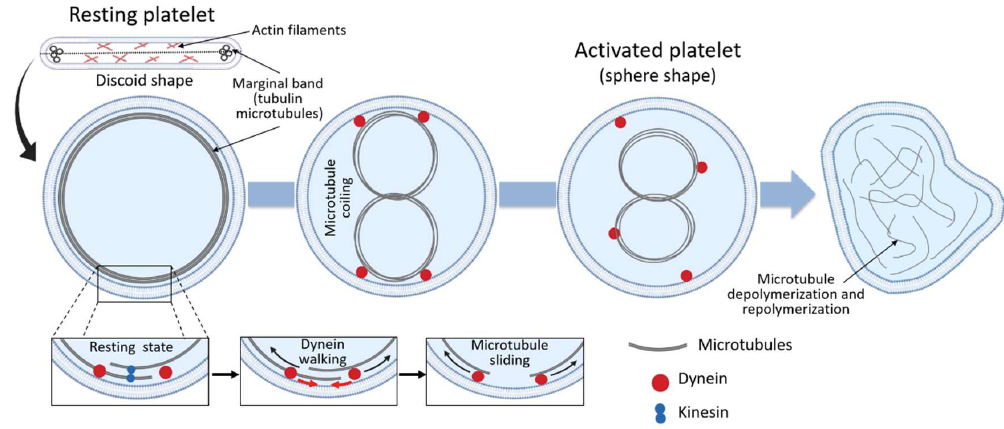
Figure 2. Microtubules coiling during platelet activation.